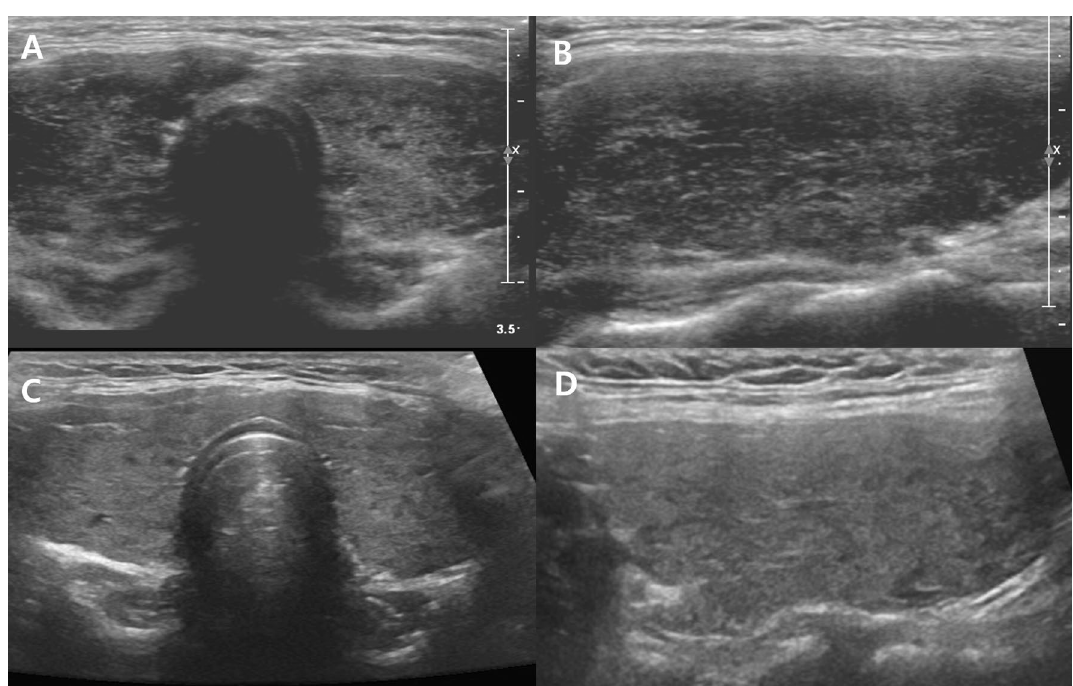
Figure 9. A 14-year-old female patient: initial US ( A and B ) was classified as G4. On follow-up US after one year, hypoechogenicity and heterogeneity were improved and classified as G3 ( C and D ). Simultaneously, TFT results were also improved (overt hypothyroidism to